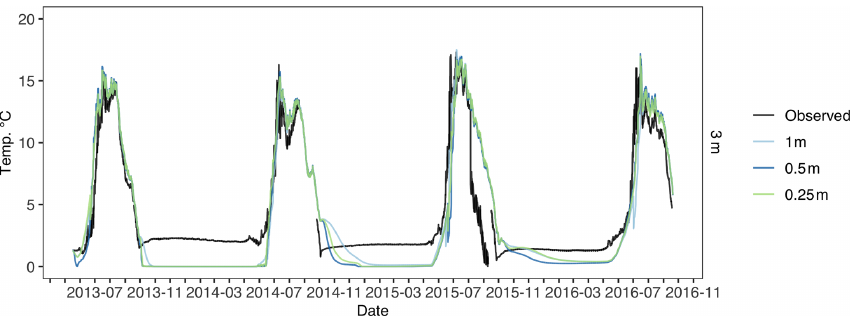
Figure D5. Toolik 3m water temperature across different water vertical resolution simulations. Observed water temperature is in black, 1m vertical resolution is in light blue, 0.5m vertical resolution is in blue, and 0.25m vertical resolution is in green.